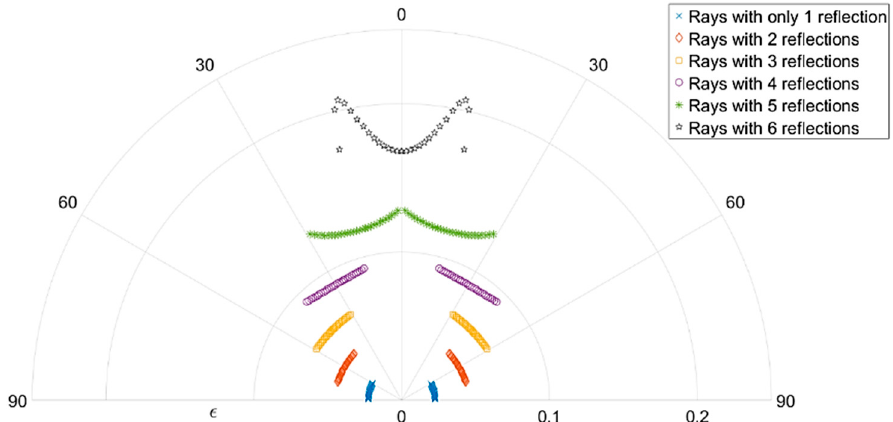
Figure 9. Polar diagrams of the NIR emissivity computed using ray tracing of each of the five emis- sion components through the sides of the groove composed of aluminum for different numbers of reflections at an opening angle 30°.